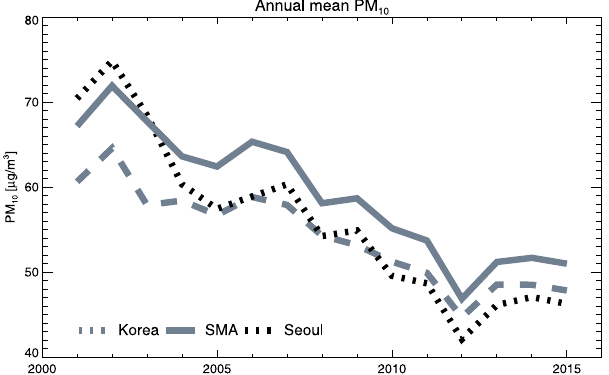
Figure 1. Time series of observed annual mean surface PM 10 concentrations over Seoul (30 sites), the SMA (112 sites), and South Korea (247 sites) from 2001 to 2015. Box plots indicate 25 th , 50 th , and 75 th percentiles of the SMA PM